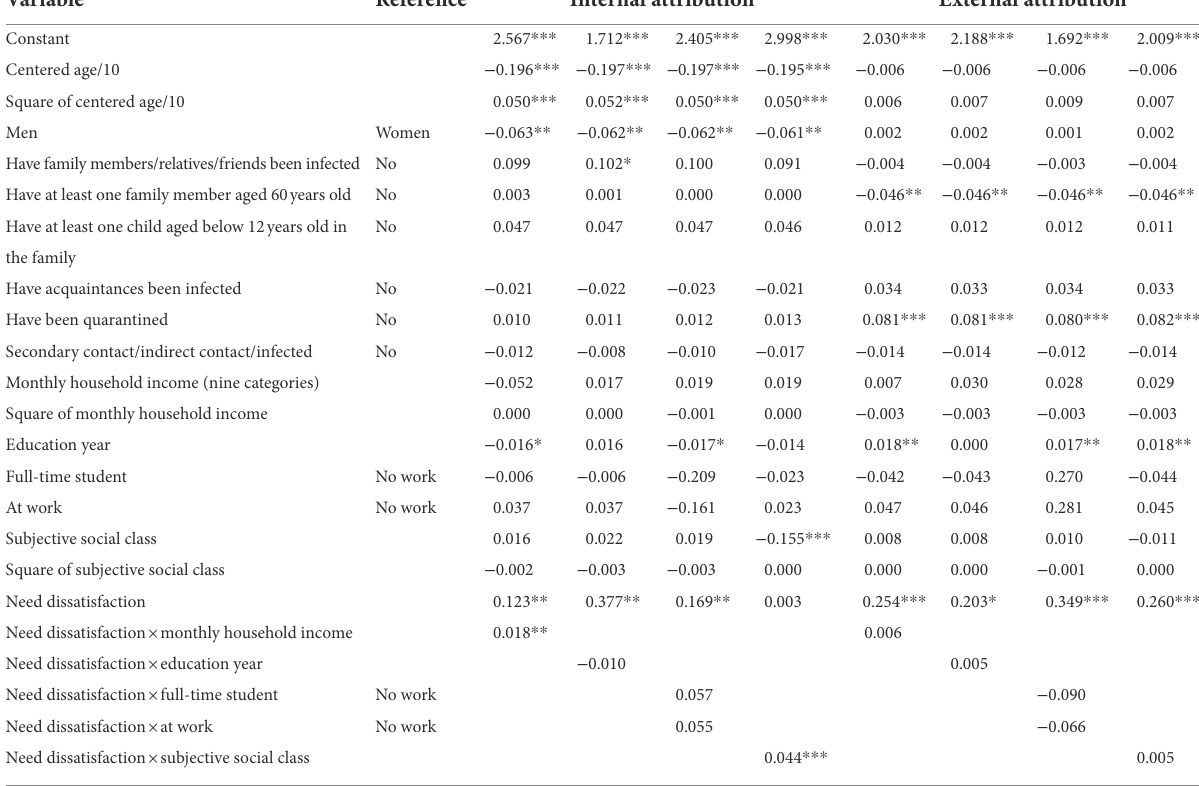
TABLE 5 Moderation